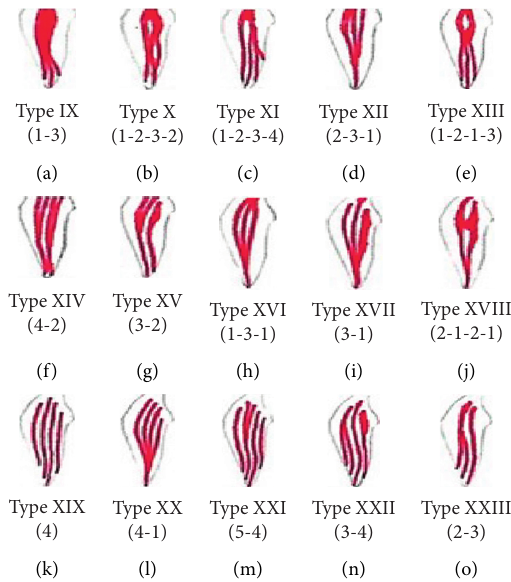
Figure 2: Vertucci’s classification of root canal morphology from type I to type VIII.